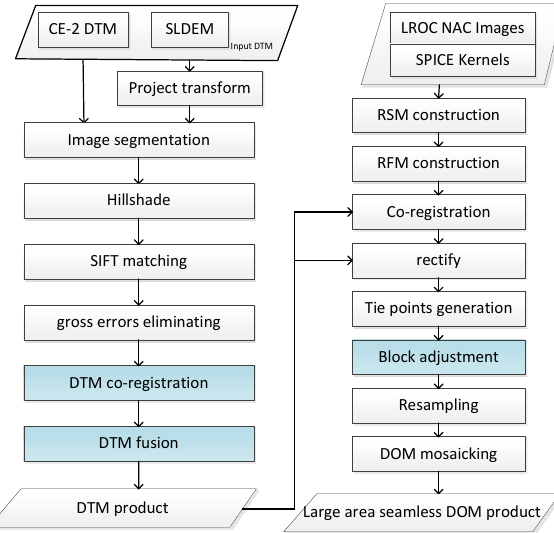
Figure 1. Flowchart of DTM fusion and DOM